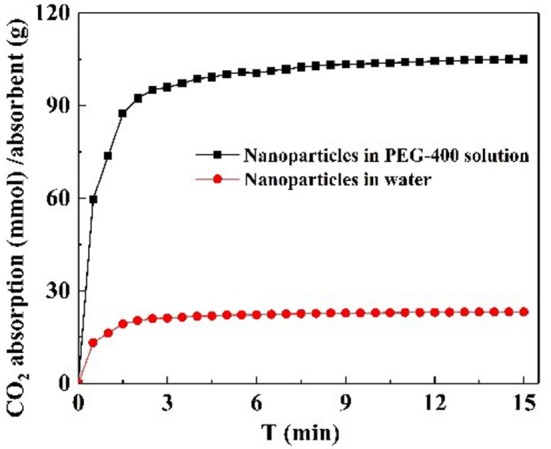
CO2 adsorption of NS-NR2 in different dispersants.